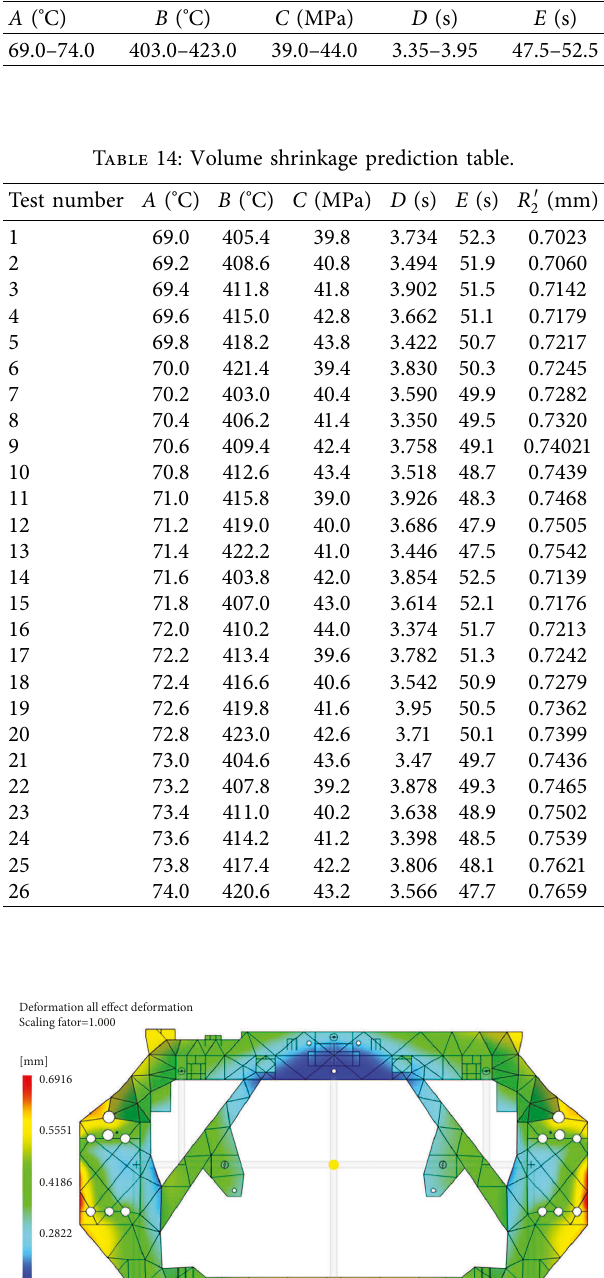
Table 13: Table of parameter ranges.